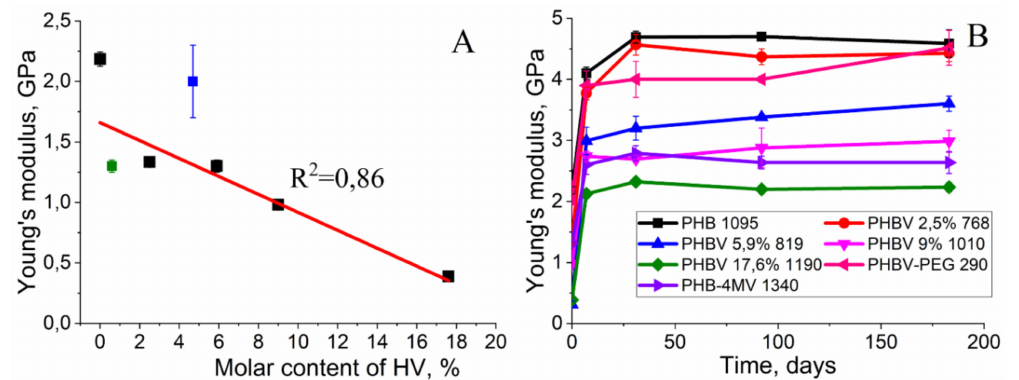
Figure 7. ( A ) Graphs of the dependence of the young’s modulus on the content of 3-HV. The green square corresponds to the PHB-4MV 1340 copolymer, and the blue square corresponds to the PHBV-PEG 290 copolymer. ( B ) Changing Young’s modulus of the polymers in the process of enzymatic